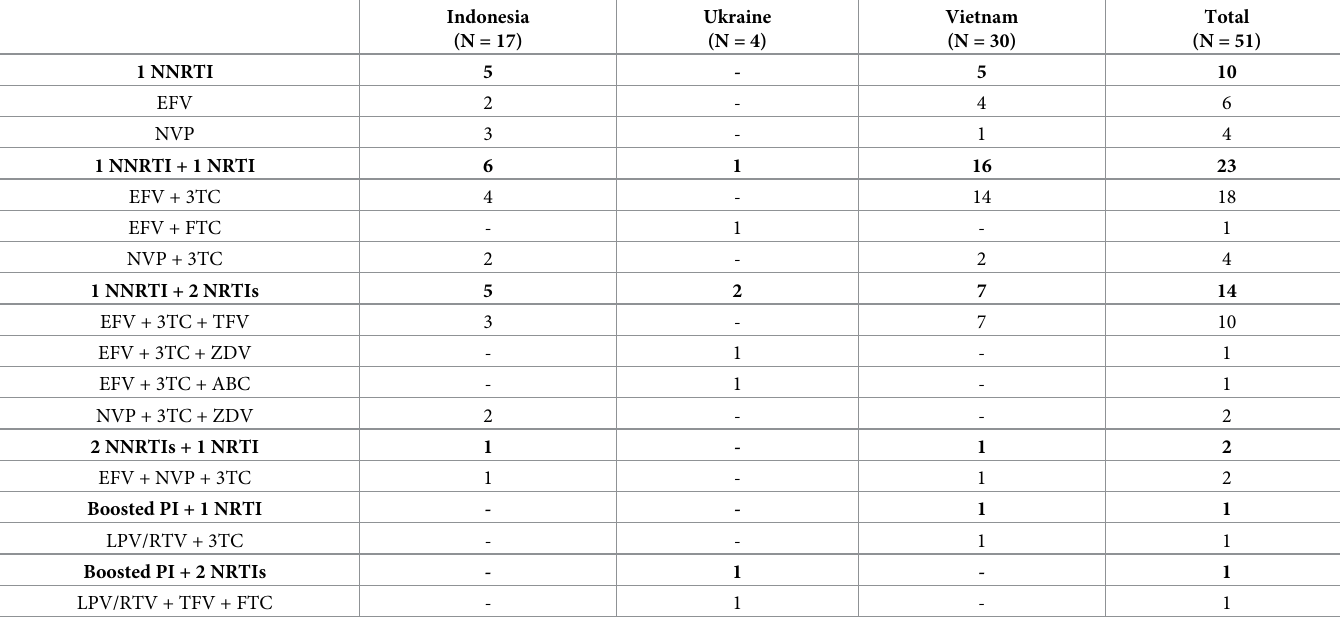
Table 1. Patterns of antiretroviral drugs detected.